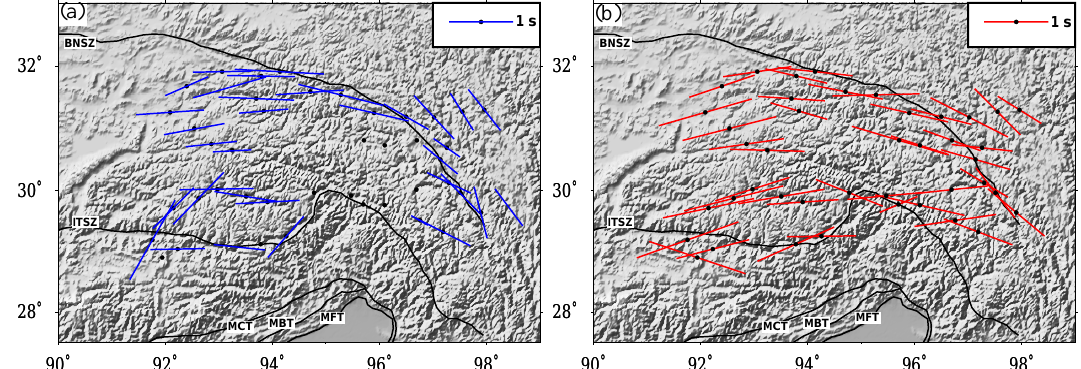
Figure 7. The tectonic and topographic map of the southeastern Tibetan region, which represents the station average splitting parameters: (a) the previous SKS-derived splitting measurements (solid blue bar) performed by Sol et al. (2007) and (b) the direct S -wave-derived splitting measurements (solid red bar, this study). The length of the solid bars in each panel indicates the strength of anisotropy and is scaled by station-averaged splitting time delays. Azimuth of the solid bars indicates the fast polarization direction (FPD). Black circles show location of the seismic stations used in this study. (MFT: Main Frontal Thrust; MBT: Main Boundary Thrust; MCT: Main Central Thrust; ITSZ: Indus–Tsangpo suture zone; BNSZ: Bangong–Nujiang suture zone).